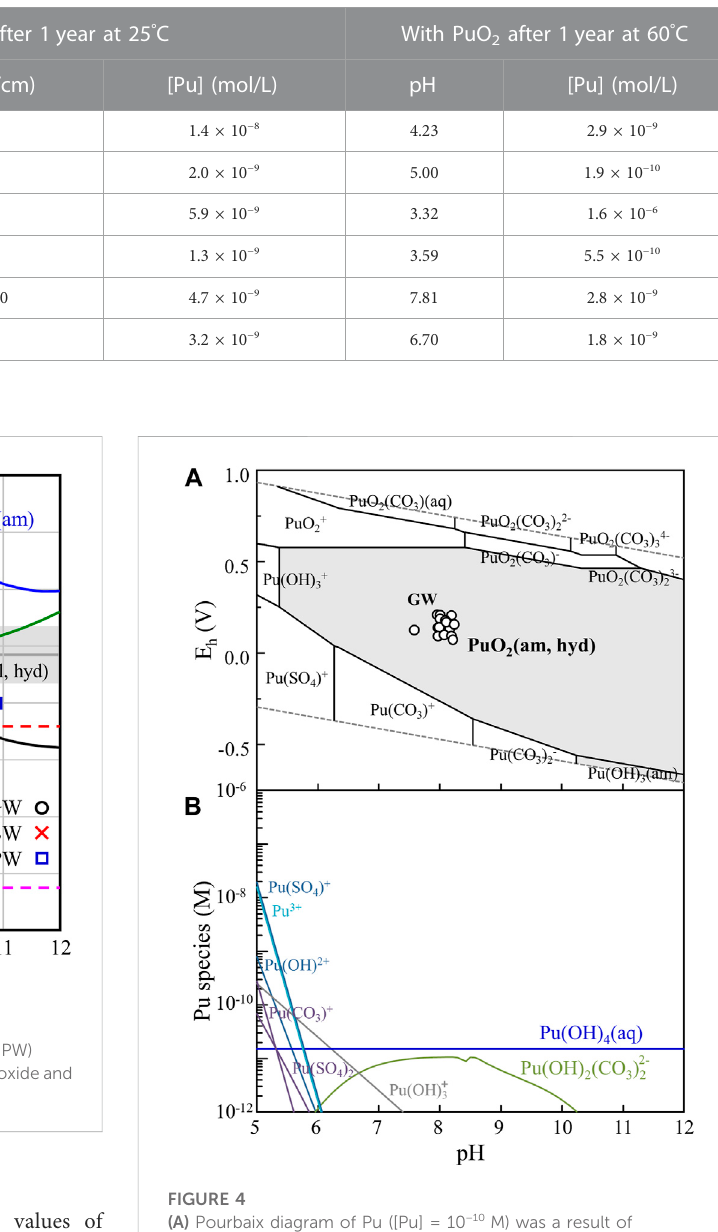
TABLE 3 Representative [Pu], pH and conductivity of natural water samples with PuO 2 measured after 1 year of reaction time at 25 ° C and 60 ° C, respectively.